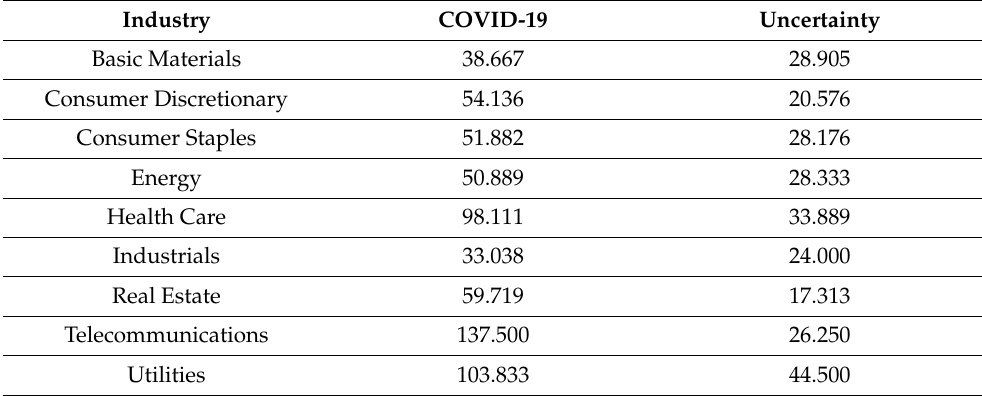
Table 1. COVID-19 disclosure and uncertainty score across